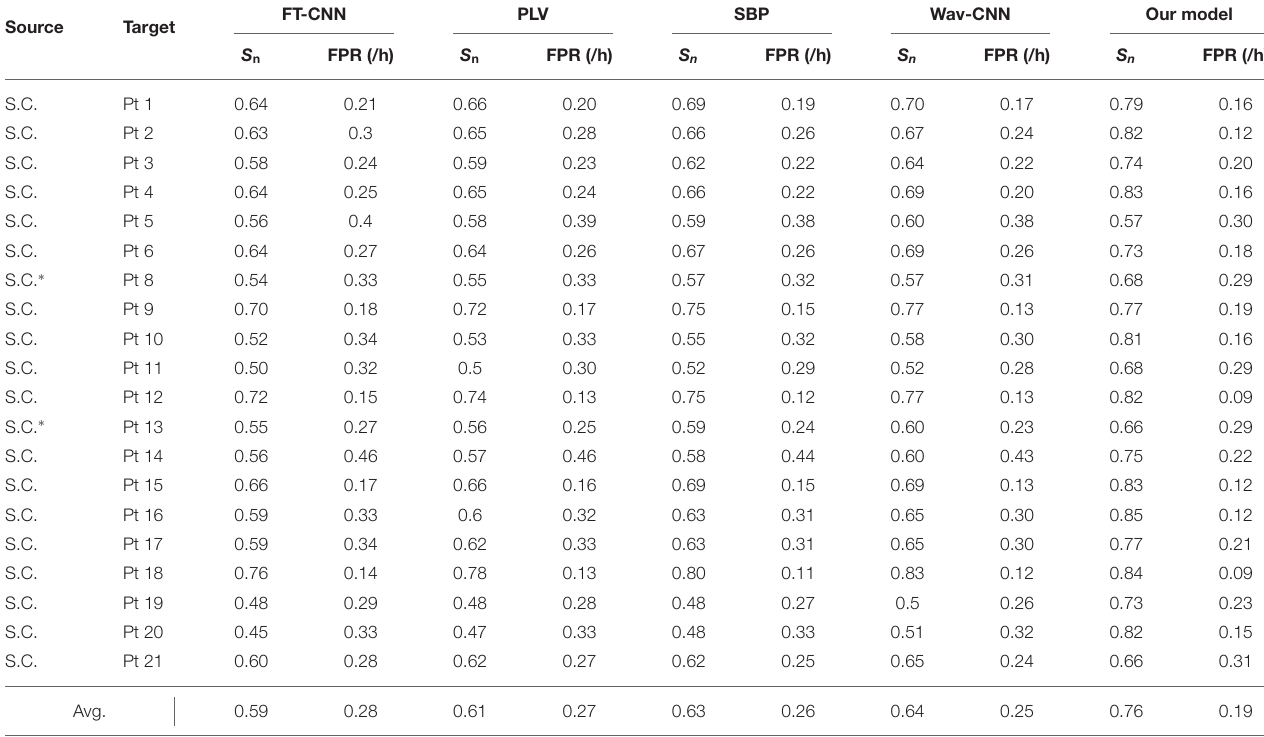
TABLE 3 | Results compared with conventional methods on the Freiburg Hospital database. Source